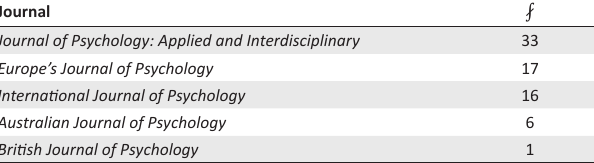
TABLE 1: Work code frequency in journals.